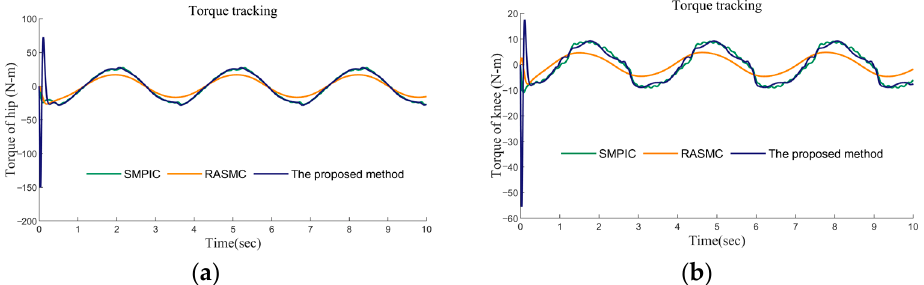
Figure 8. The time history of the joints. ( a ) The time history of hip torque under case 0 condition and ( b ) The time history of knee torque under case 0 condition.